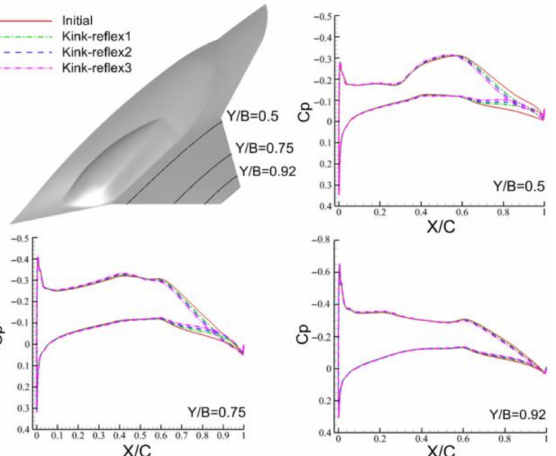
Figure 23. Pressure coefficient distributions at typical sections of the different aft-reflexed configura- tions. Ma = 0.85, α = 2 ◦